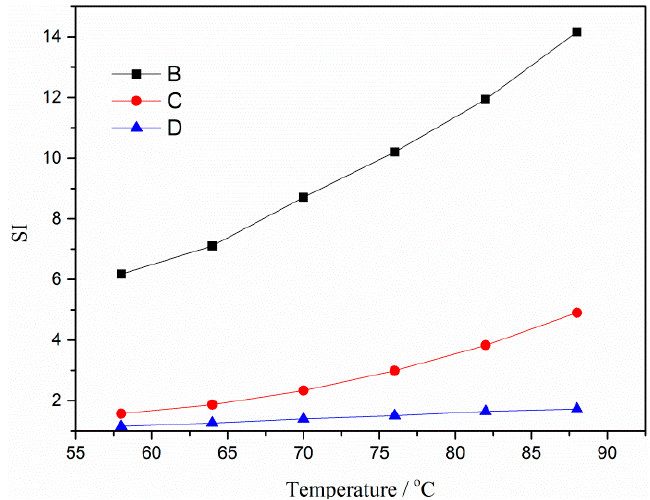
Figure 8. G*/sin δ of top and bottom samples of modified asphalt binder .